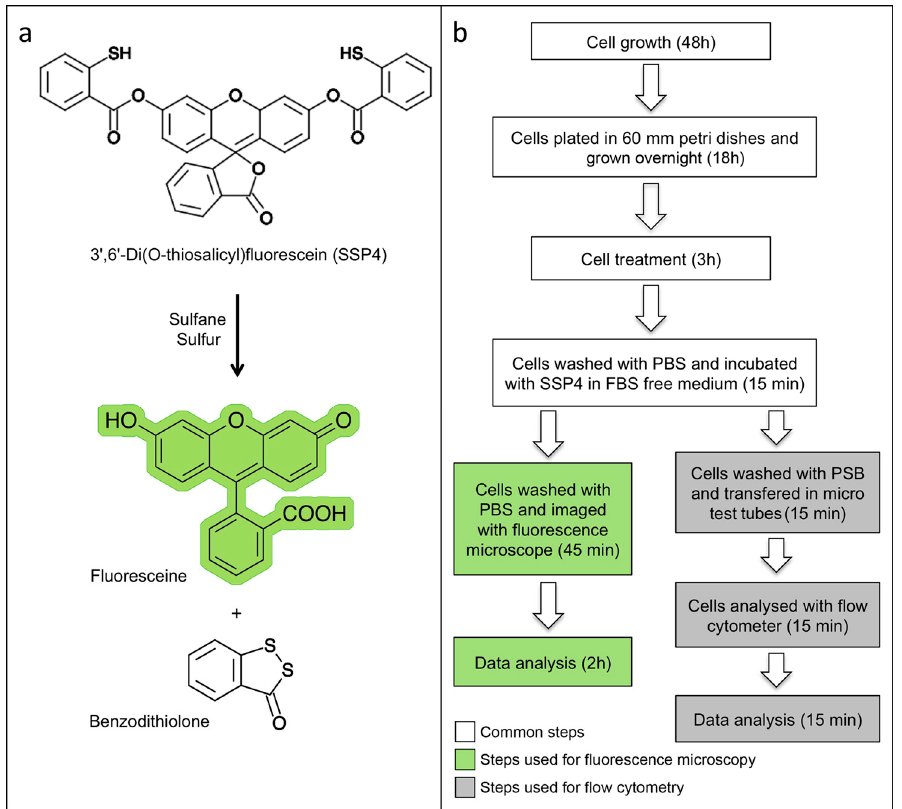
Figure 2. The principle of reaction and design of experiments with SSP4: ( a ) Sulfane Sulfur Probe 4 in presence of sulfane sulfur species cleaves fluorescein (shown in green) that could be detected at λ ex 482 nm and λ em 515 nm; and ( b ) experimental design for detection sulfane sulfurs in cells culture with fluorescence microscope and/or flow cytometer using SSP4. PBS, Phosphate-Buffered Saline; FBS, Fetal Bovine Serum.